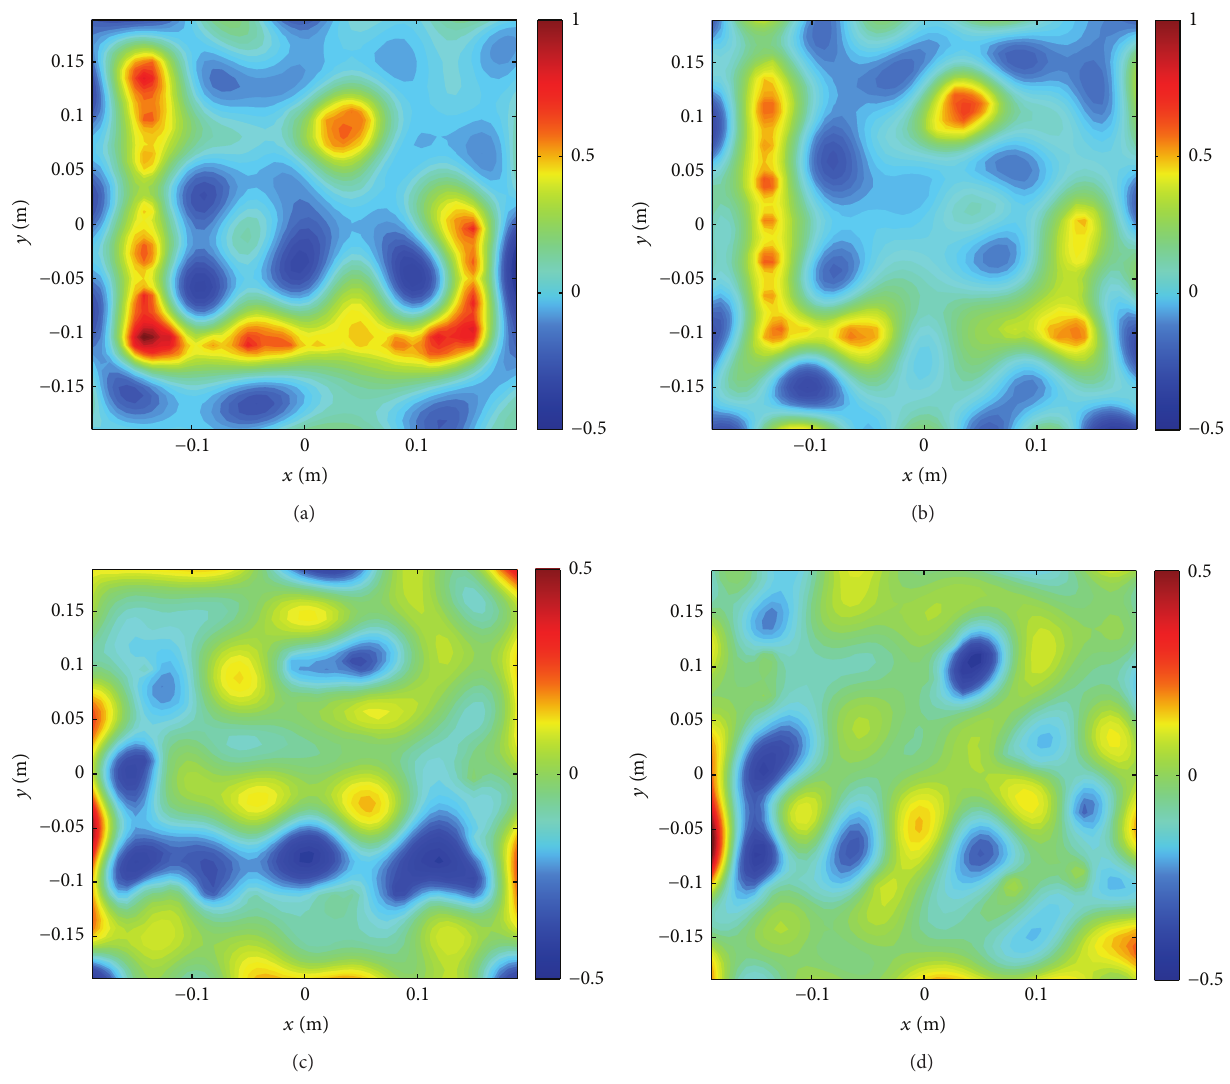
Figure 12: Example 2: QLSM reconstructions by using measurement configuration B. ((a), (c)) Real and imaginary parts of retrieved profiles in a square scanner; ((b), (d)) real and imaginary parts of retrieved profiles in a triangular scanner.